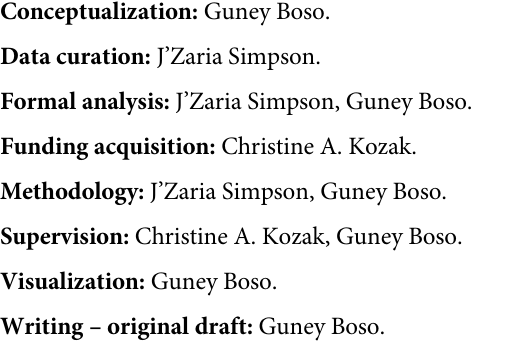
S2 Table. Viral genomes and co-opted viral genes used in this